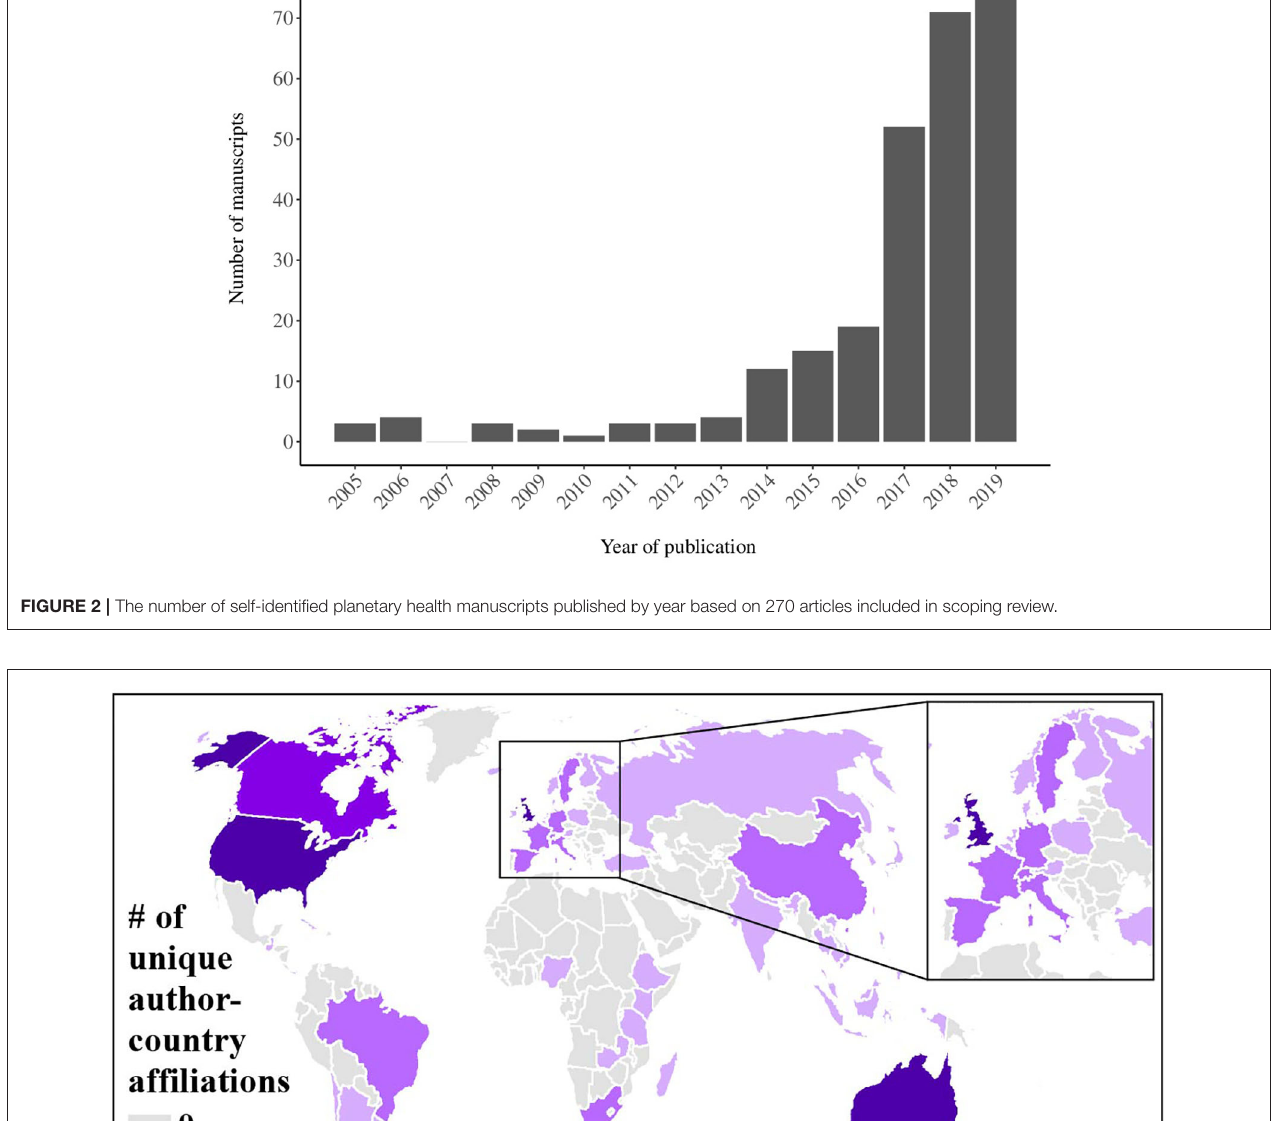
conferences, we learned that some researchers are critical of the term and reluctant to use it to describe their work for reasons such as the perception that the term is not intuitive, that it does